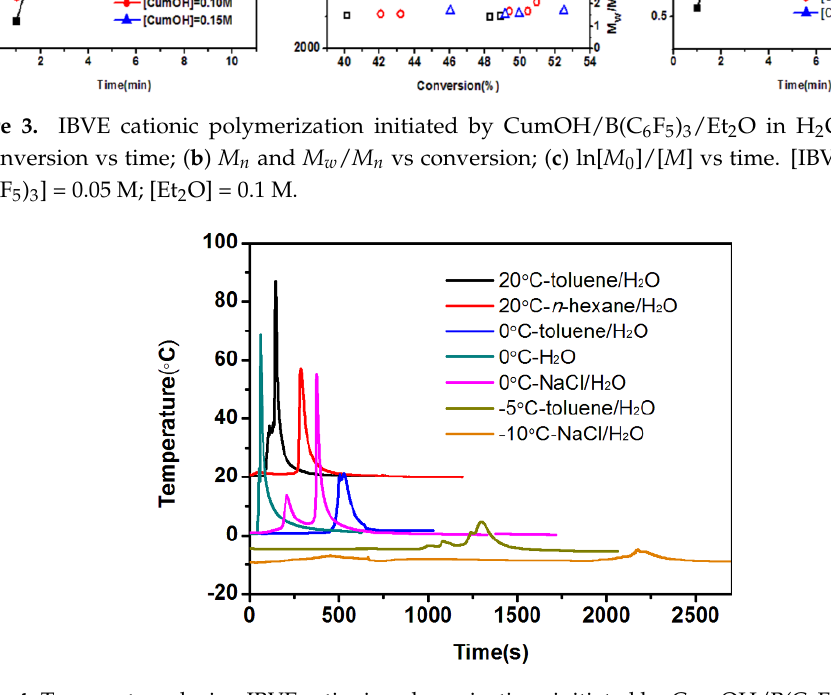
Figure 4. Temperature during IBVE cationic polymerizations initiated by CumOH/B(C 6 F 5 ) 3 /Et 2 O in an aqueous suspension: toluene: 1 mL; NaCl: 1 g; [IBVE] = 1.6 M; [CumOH] = [B(C 6 F 5 ) 3 ] = 0.05 M; [Et 2 O] = 0.1 M. Table 2. Suspension cationic polymerization of IBVE at different temperatures a